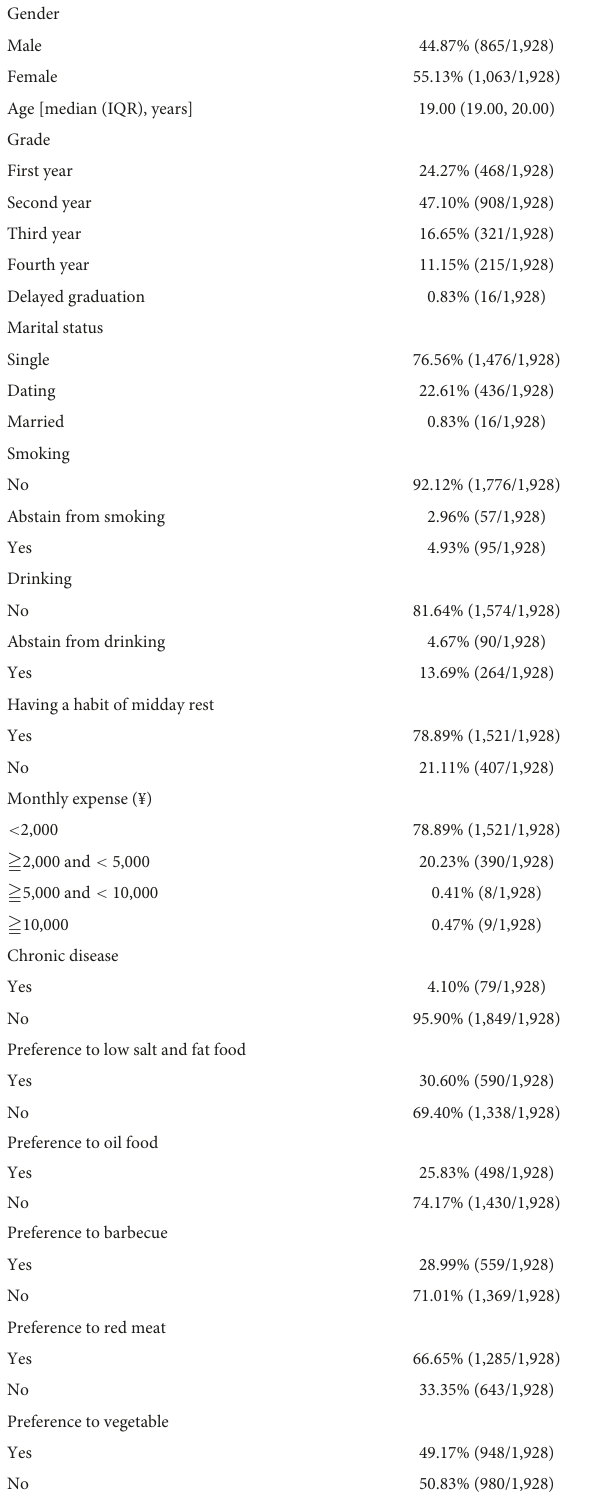
TABLE 1 Student’s demographics, living and sport habits, and mental health.